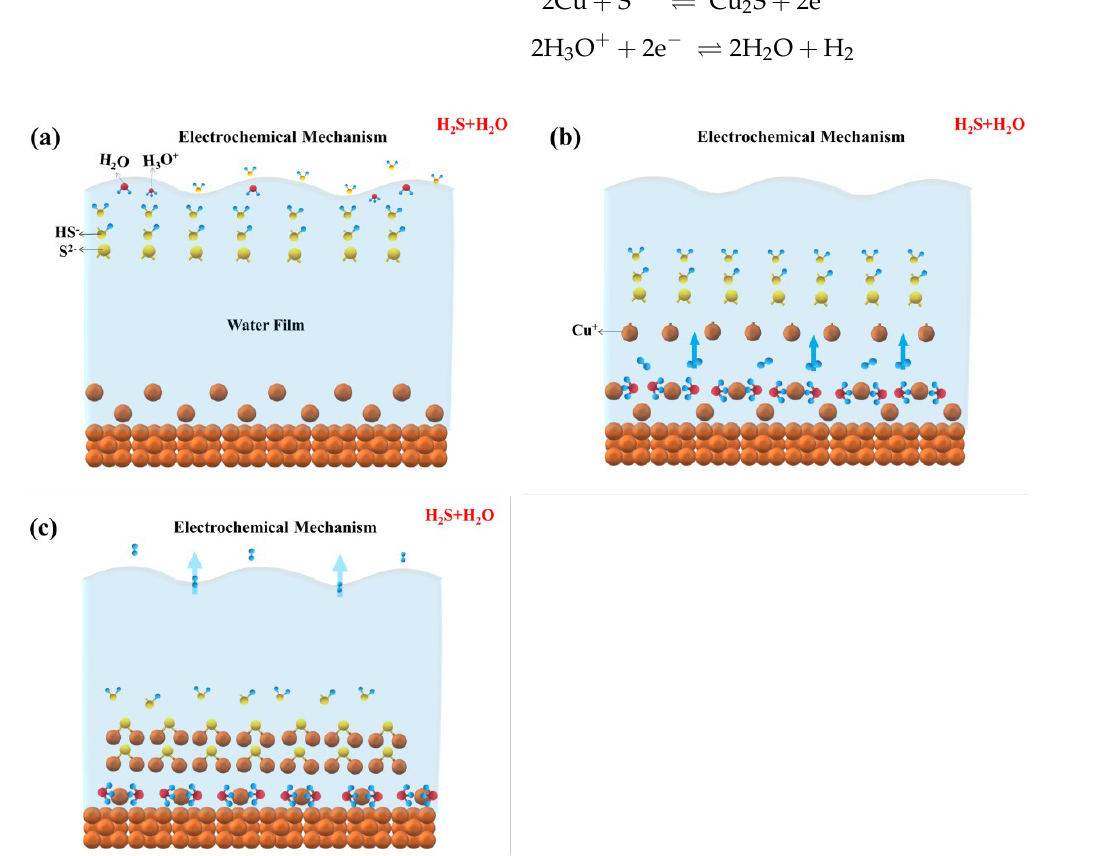
Figure 12. Schematic diagram of corrosion steps of copper sheet in LPG with H 2 S+H 2 O. ( a ) step1. ( b ) step2. ( c ) step3.